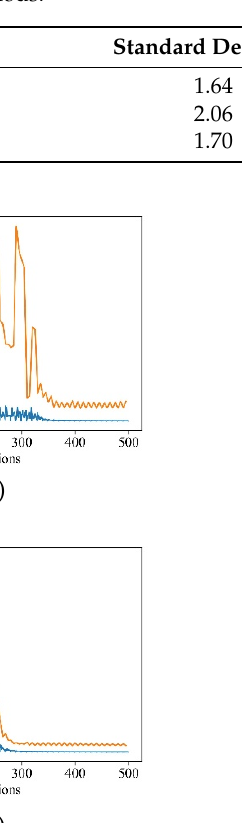
Table 3. Tiller number recognition accuracy (%) of three methods.